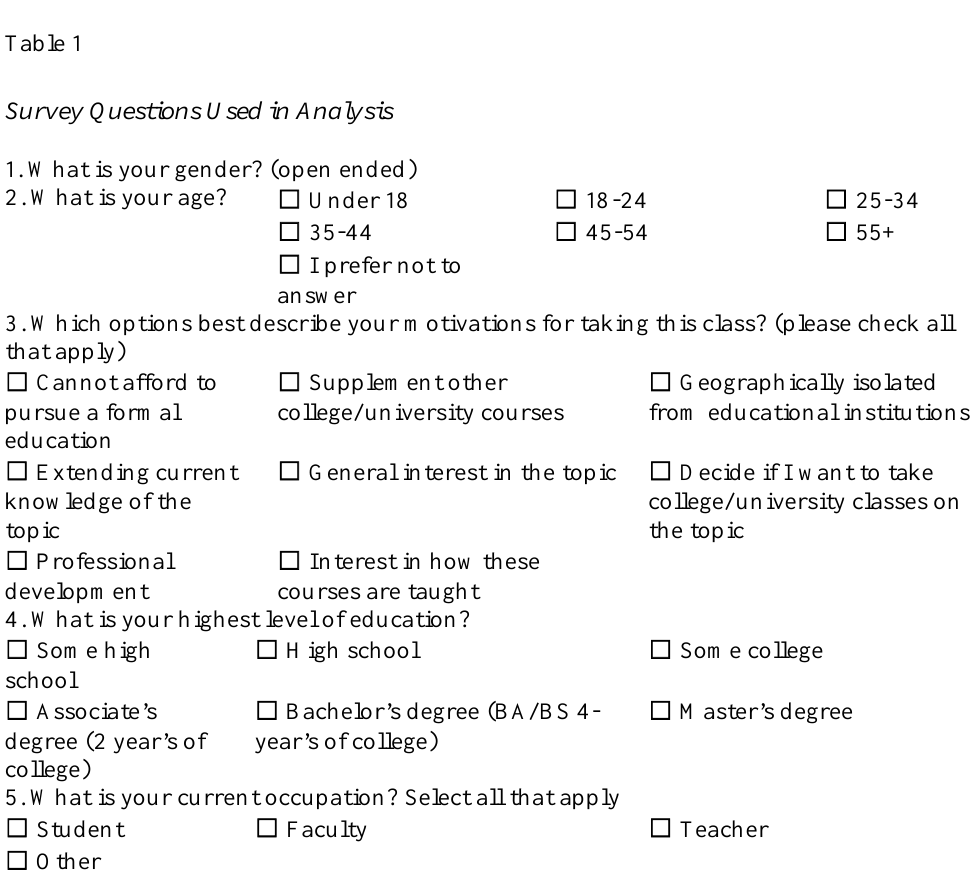
Survey Questions Used in